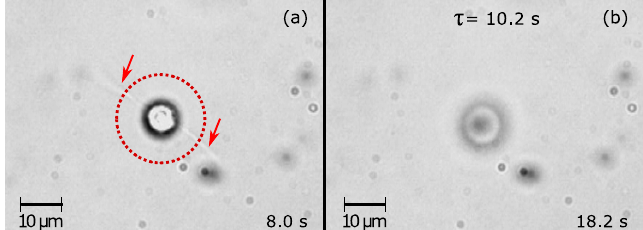
Figure 2. Two frames taken from Video S1 showing the initial and final positions of the Dunaliella in a detachment event induced by the trapping beam. ( a ) The adhered Dunaliella in the red dashed circle aligned to the trapping beam after unblocking the beam. The adhered flagella are indicated with the red arrows. ( b ) At 18.2 s ( τ = 10.2 s), the cell was detached and moved upwards, appearing here out of focus but still remaining in the optical